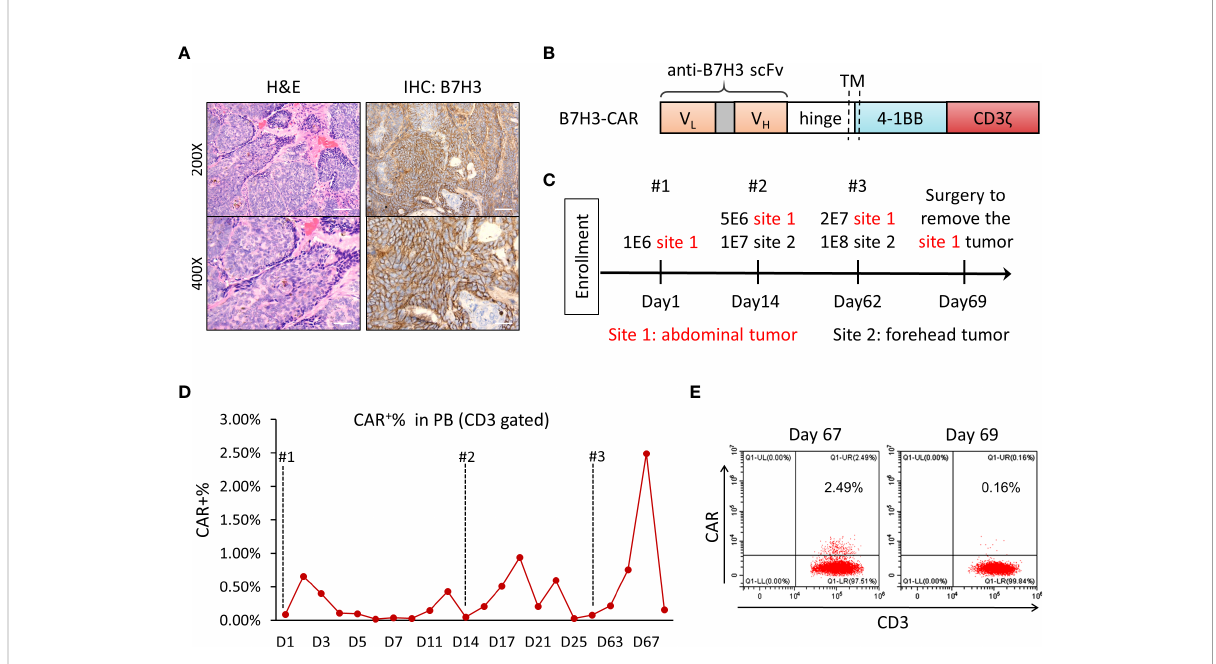
FIGURE 1 Clinical examinations in the sequential injection of B7-H3 CAR-T cell therapy. (A) Histological analysis of basal cell carcinoma sections by hematoxylin and eosin (H&E) and anti-B7-H3 staining for diagnosis. Slides were analyzed and scored by two individual pathologists independently. (C) The protocol of B7-H3 (B) Schematic diagram of B7-H3 CAR vector. V L , variable L chain; V H , variable H chain; TM, transmembrane domain. CAR-T injection. Intratumoral injection was performed at two tumor sites for a total of three times, on days 1, 14, and 62. (D) Detection of CAR-T (CD3 + CAR + ) cells in peripheral blood during immunotherapy. (E) Flow cytometry analysis of CD3 + CAR + cells in peripheral blood on days 67 and 69 after CAR-T cell injection. FITC-labeled recombinant B7-H3 protein was used to detect B7-H3-CAR transduced CD3 +